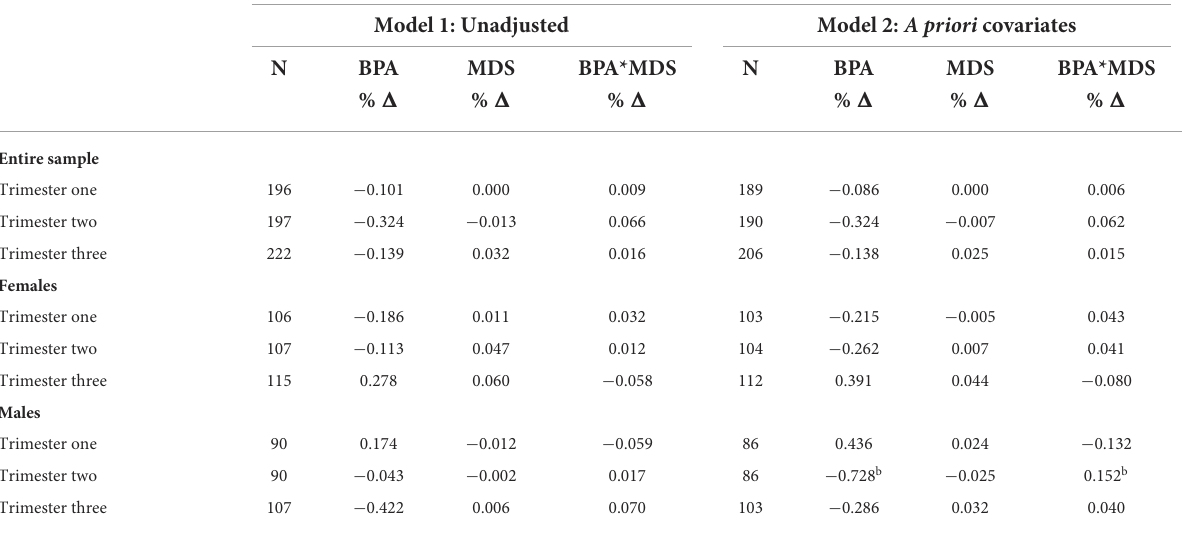
TABLE 4 Percent changes in adolescent MRS per 1-unit increase in ln-transformed prenatal maternal urinary BPA. Trimester of